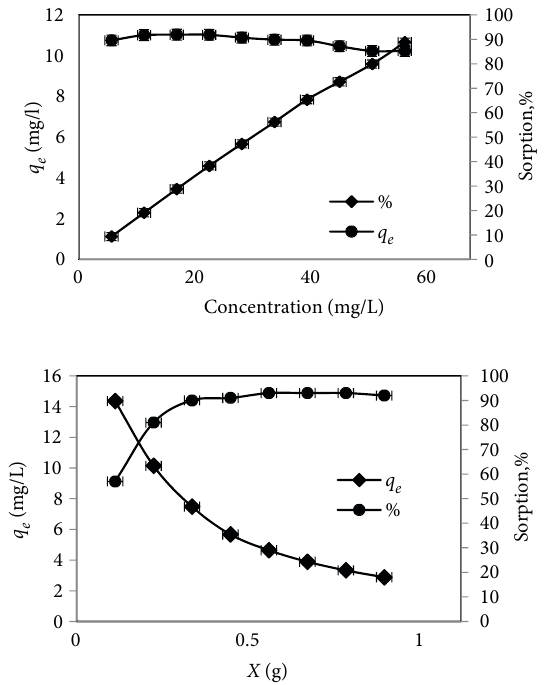
Fig. 6. (a) Effects of initial Cu 2+ concentrations on biosorption capacity and yield (b) Effects of biosorbent quantity on biosorption capacity and